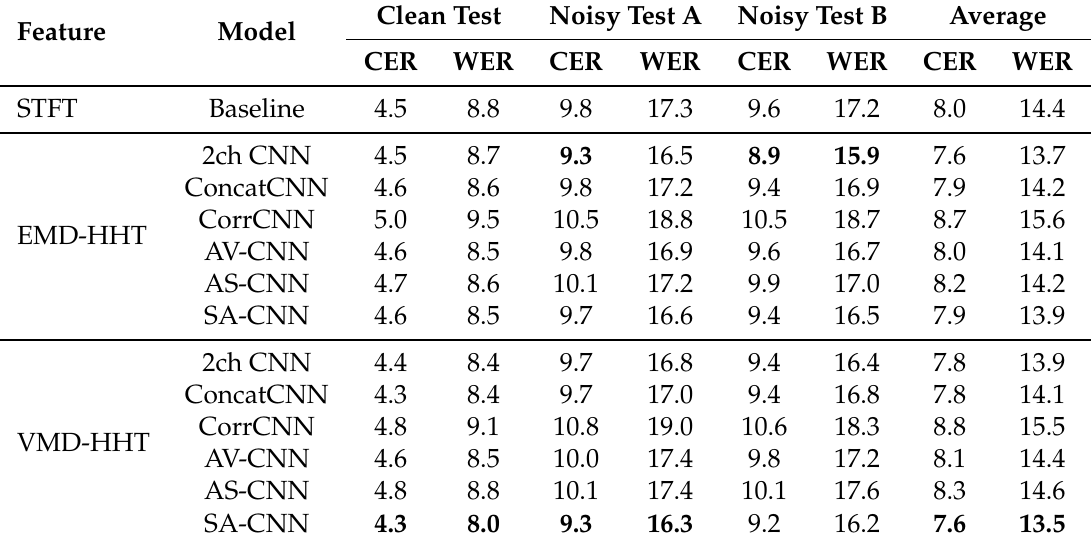
Table 4. CER and WER results (%) of clean and noisy tests for all the models trained on the WSJ dataset. Noisy Test A has the same noise types as the training set. Noisy Test B has a noise type that is not used during training (The best results for each set are highlighted with bold